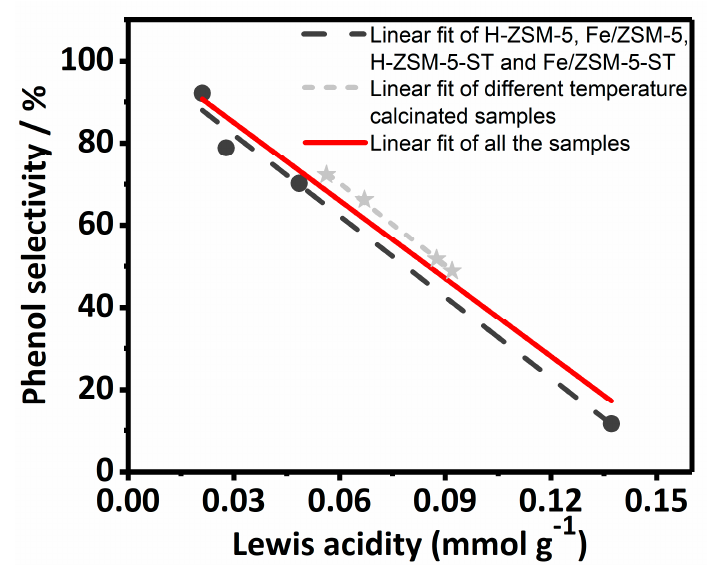
Figure 8 . Relationship between the amount of Lewis acidity and the initial N 2 O selectivity (TOS = 20 min) to phenol. The black points ( ● ) represent H-ZSM-5, Fe-ZSM-5, H-ZSM-5-ST and Fe-ZSM-5-ST; the grey points ( ) refer to different temperature calcinated samples.